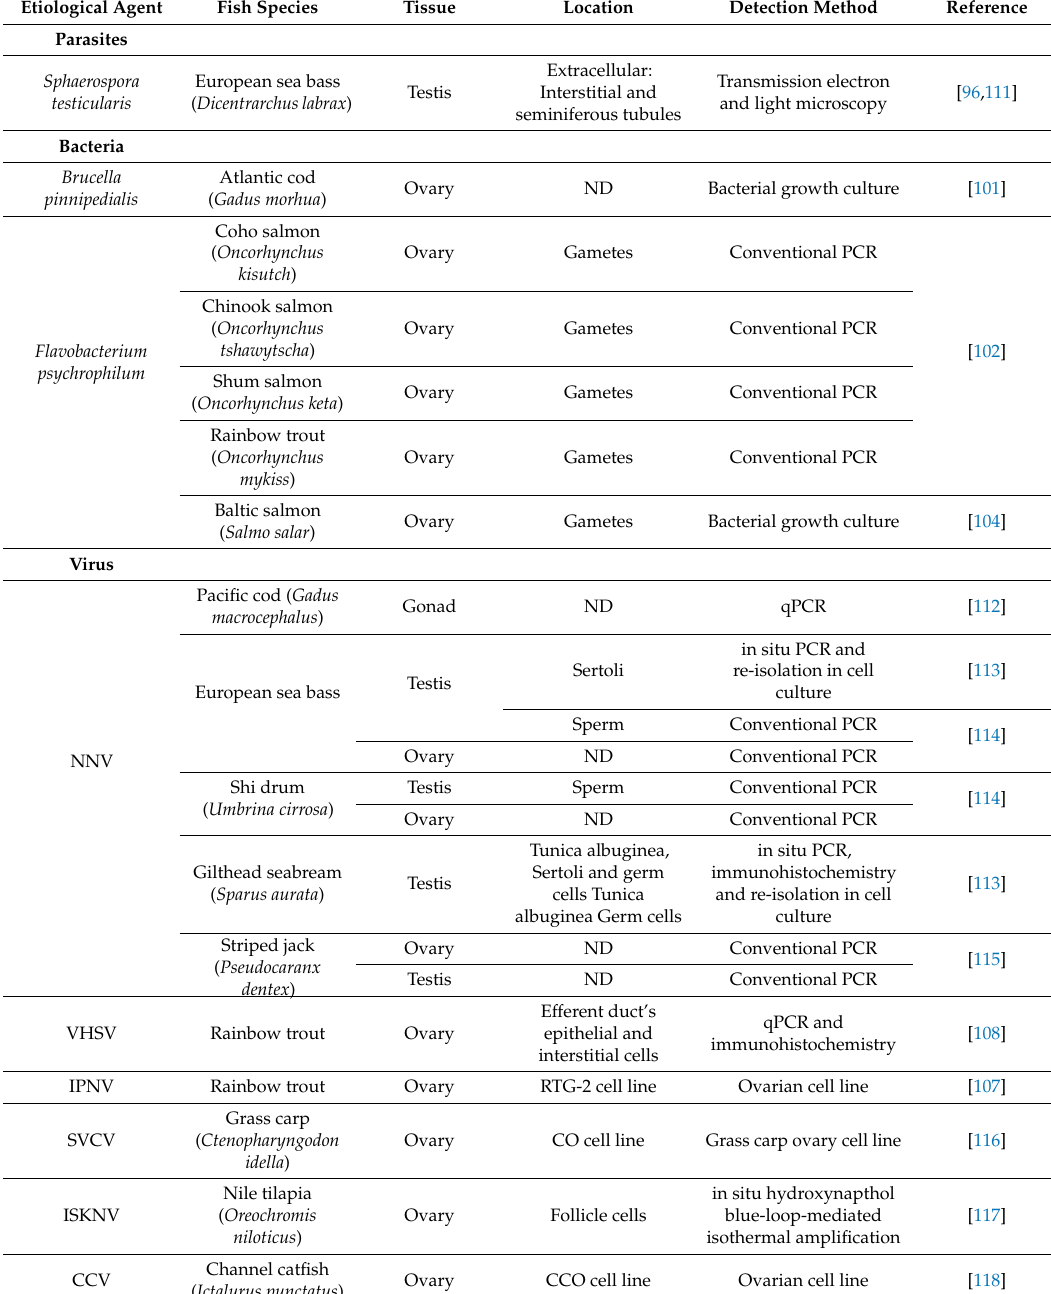
Table 2. Etiological agents reported to infect ovarian or testicular cells of several fish species. NNV, nodavirus; VHSV, viral hemorrhagic septicemia virus; IPNV, infectious pancreatic necrotic virus; SVCV, spring viremia of carp virus; ISKNV, infectious spleen and kidney necrosis virus; CCV, channel catfish virus; qPCR, real-time PCR; RTG, rainbow trout gonad; CO, grass carp ovary; CCO, channel catfish ovary; ND, not